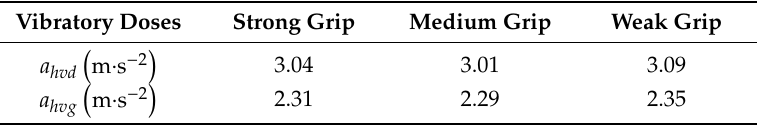
Table 6. Weighted e ff ective values of acceleration